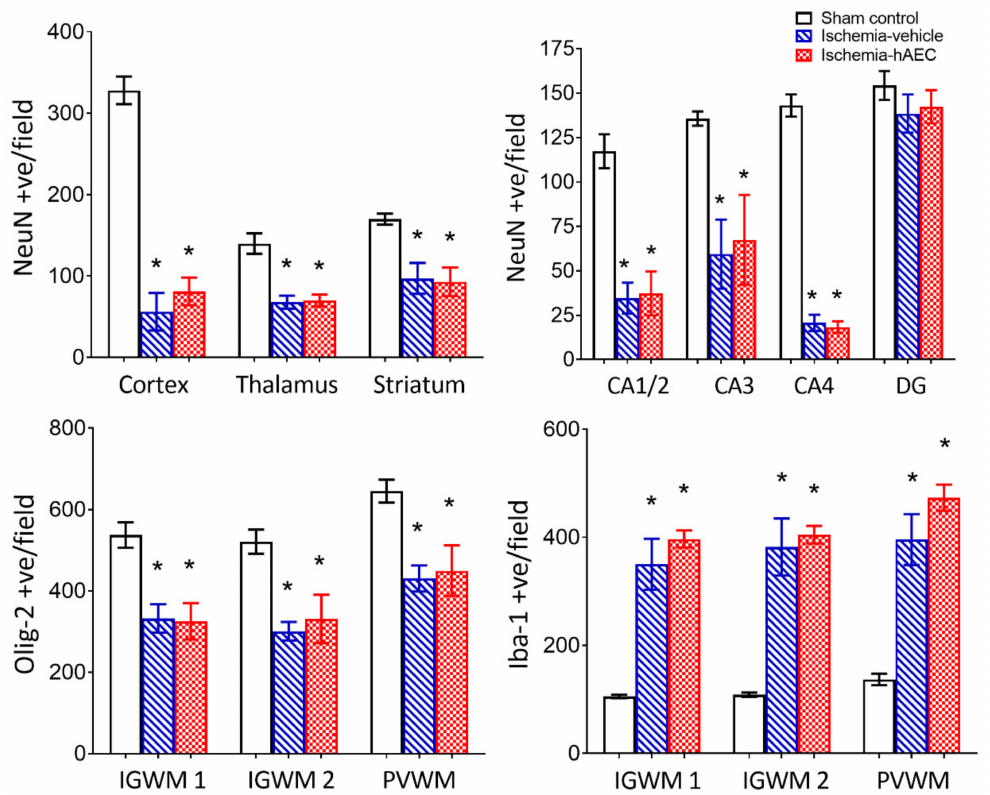
Figure 3. Neuronal number in the cortex, thalamus and striatum ( top left ) and CA1/2, CA3, CA4 and dentate gyrus of the hippocampus ( top right ), Olig2-positive total oligodendrocyte number ( bottom left ) and Iba1-positive microglial number ( bottom right ) in the sham control (n = 8), ischemia-vehicle (n = 7) and ischemia-hAEC groups (n = 6). Data are mean ± SEM * p < 0.05 vs. sham